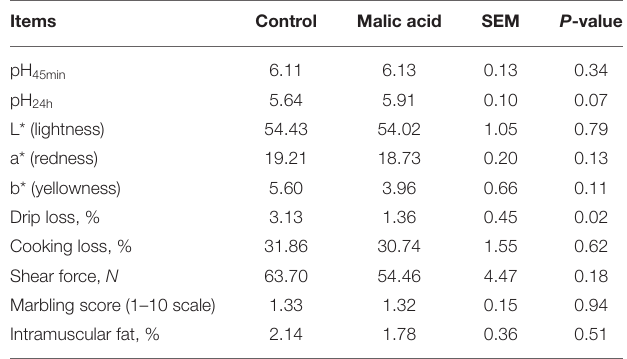
TABLE 2 | Effects of dietary malic acid supplementation in weaned piglets on the meat quality of finishing pigs ( n = 6).